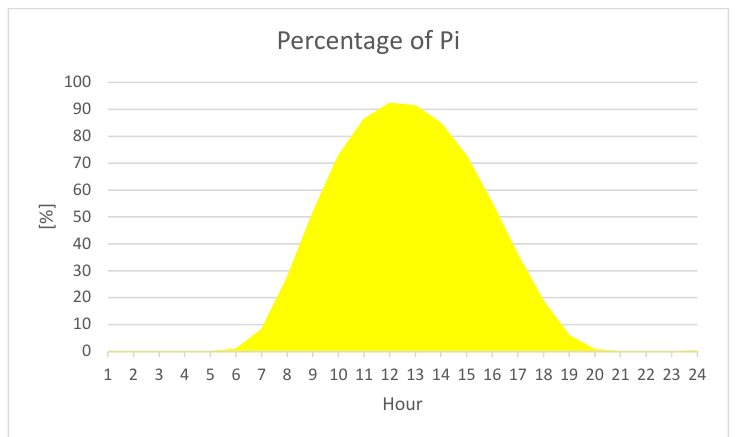
Figure 9. Average hourly operational output of the PV systems in Romania, in percentage.